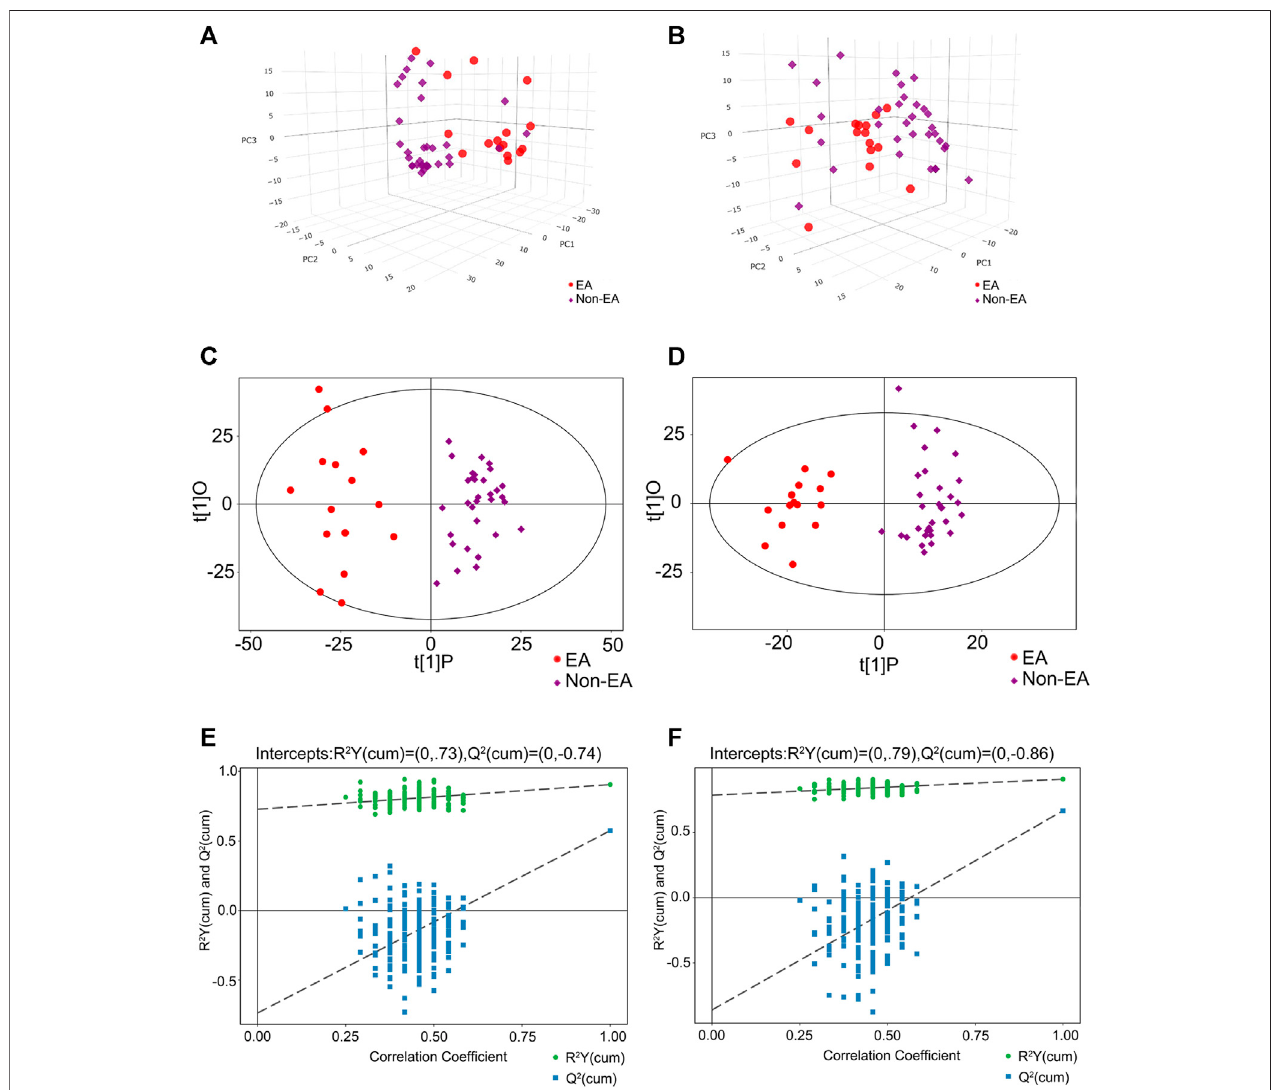
FIGURE 2 | Multivariable analysis and selection of discriminant variables with both positive and negative ion modes between the EA group and the non-EA group. ThePCAanalysesweredemonstratedas (A) (the positiveionmodel) and (B) (thenegativeionmodel)betweenthetwogroups. (C) and (D) revealedtheOPLS-DAscore plots with further permutation tests [ (E) in the positive mode and (F) in the negative mode] between the two